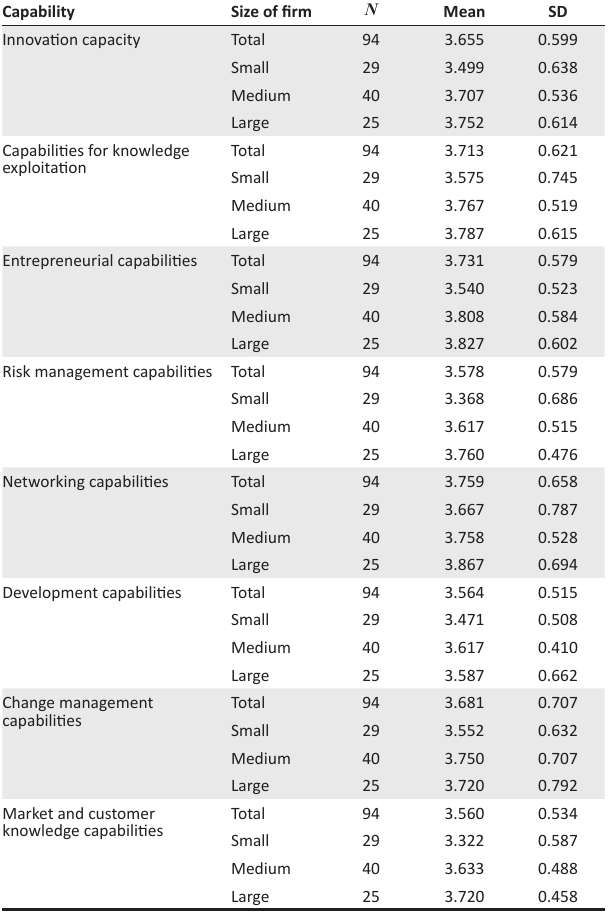
TABLE 1: Innovation capacity and sub-dimension composite scores.